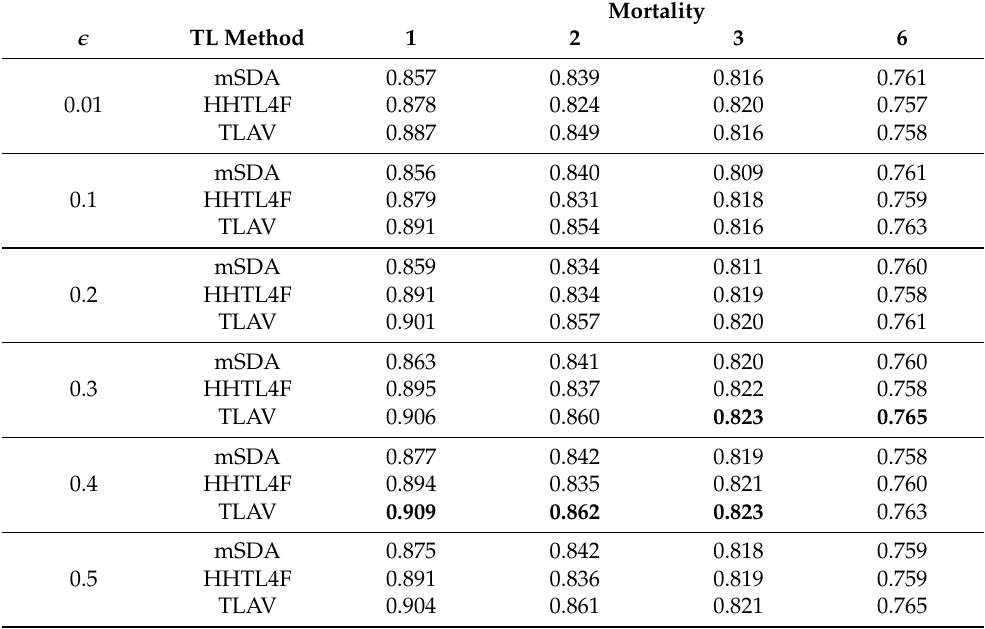
Figure 8. Evaluation of TLAV changing the dimension of the codes. Table 3. Comparison results applying TLAV with mSDA and HHTL4F using AVG codes concept and varying similarity threshold (cid:101) . In bold, the best predictive models for each mortality horizon.